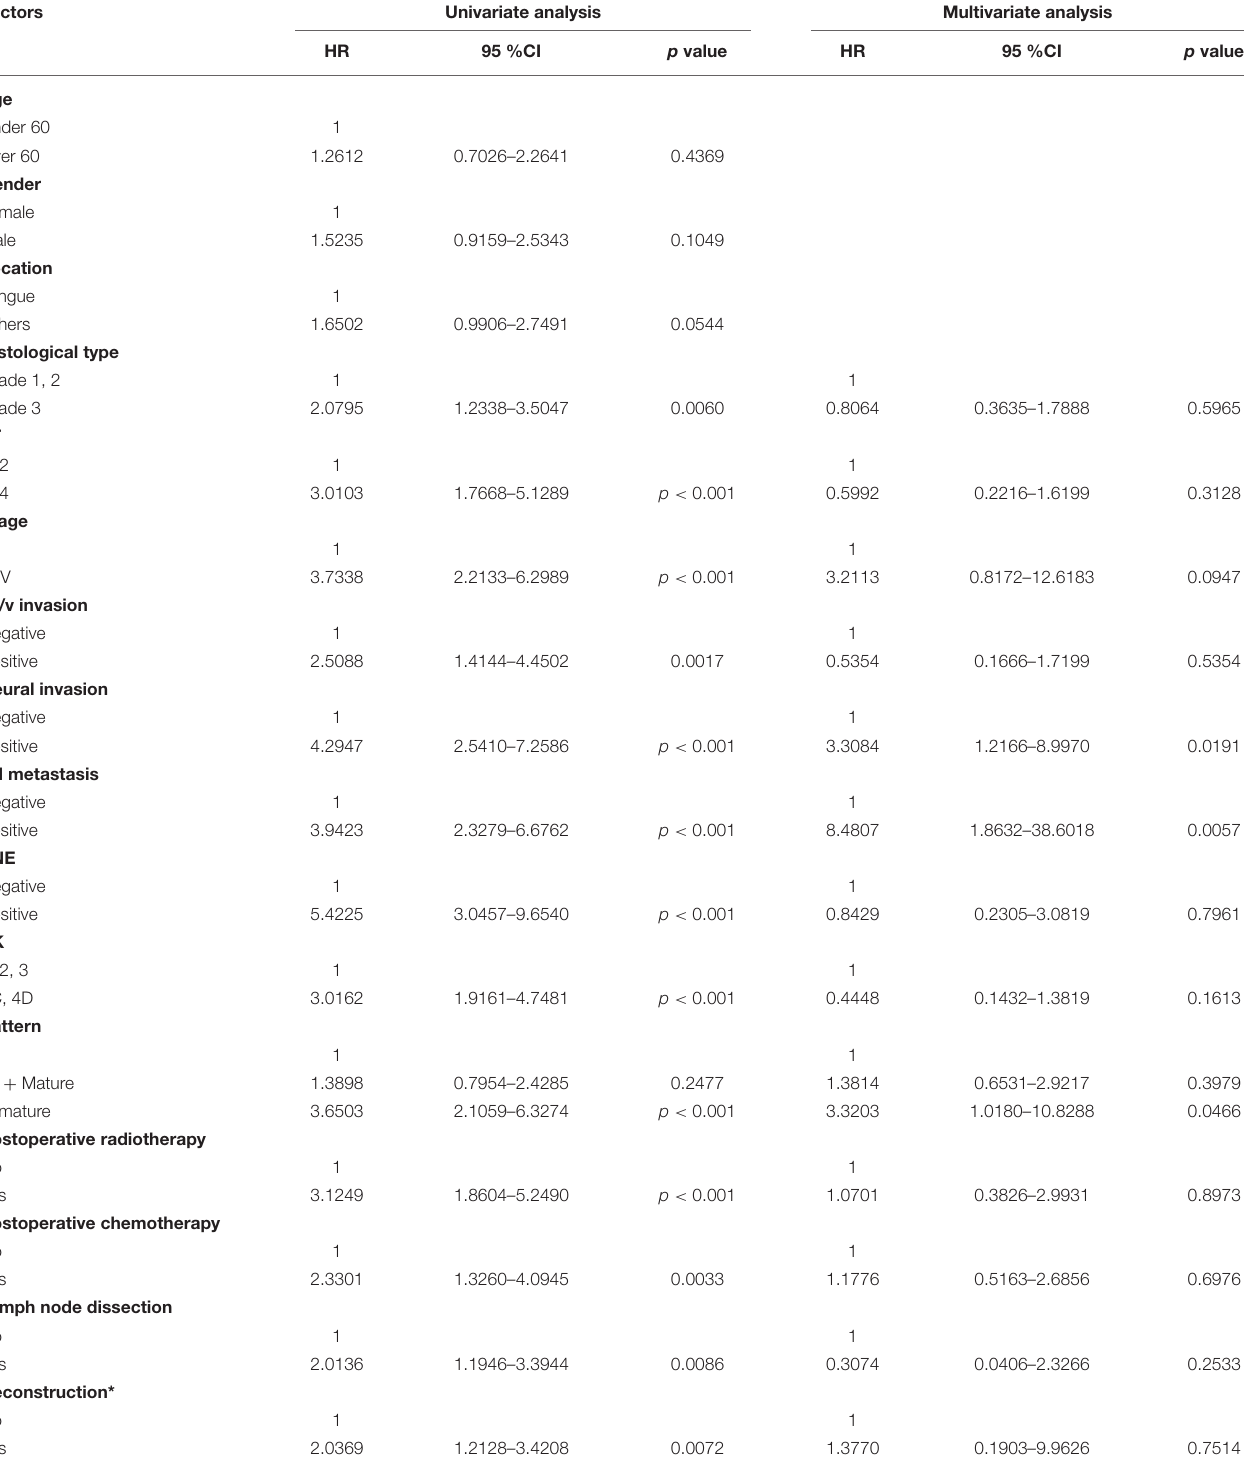
TABLE 3 | Univariate and multivariate analyses of overall survival. Factors Univariate analysis Multivariate